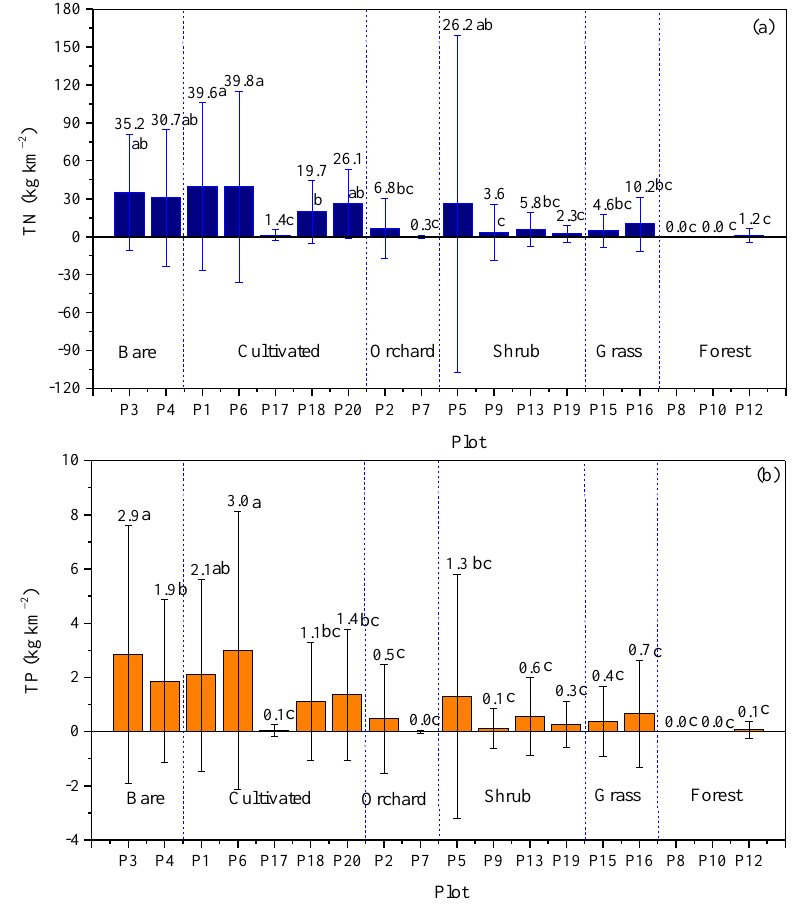
Figure 5. Event-averaged total nitrogen (TN) ( a ) and total phosphorous (TP) ( b ) loss rates from the plots in the study area. Note: Average values on the columns with the same letter are not significantly different at p = 0.05, as determined by Fisher’ protected least significant difference test. The numbers on the X axis represent runoff plots. For example, the first number 3 represents Plot 3.